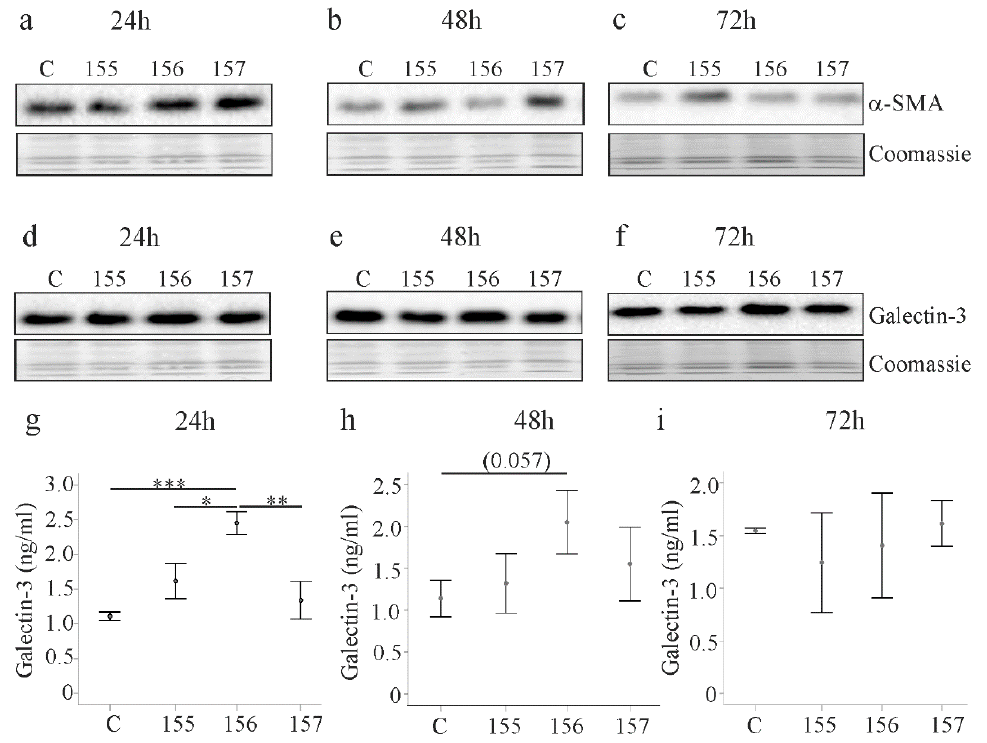
Figure 4. Alpha-smooth muscle actin ( α -SMA) and galectin-3 in LX-2 cells expressing chemerin